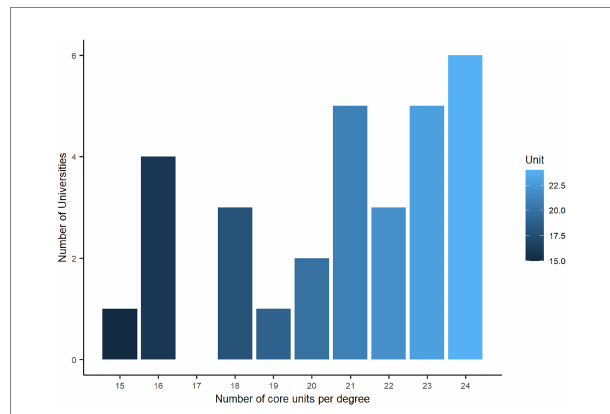
FIGURE 1 Distribution of universities by number of core units within Exercise and Sport Science (EXSS)